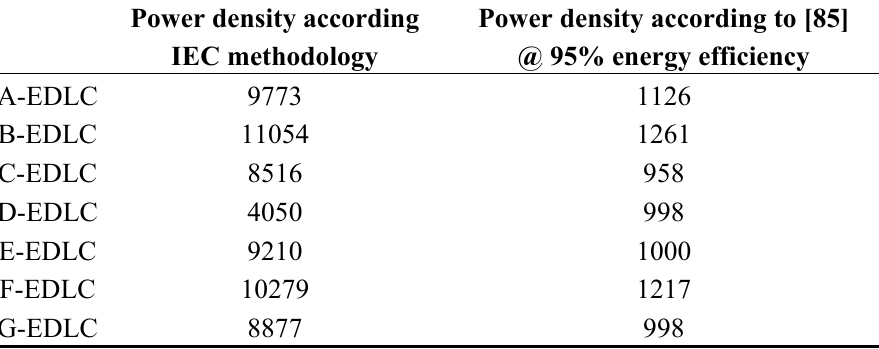
Table 8. Power density results of